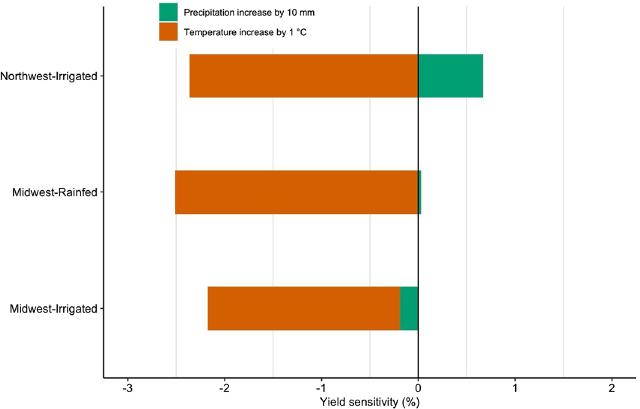
Figure 1. Sweet corn yield sensitivity to changes in growing season average temperature and total precipitation across the Midwest (Irrigated and Rainfed) and the Northwest (Irrigated) using commercial crop production data from 1992 to 2018. Yield sensitivities were estimated as percent yield losses relative to the mean yield for each production region.